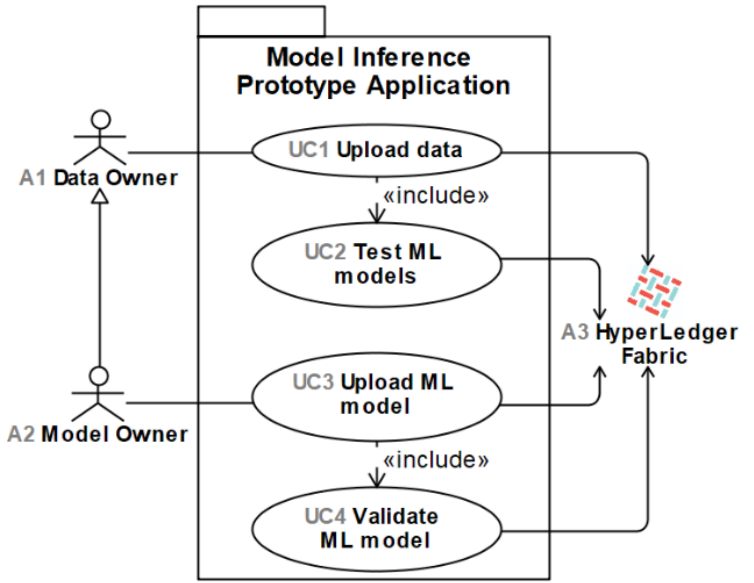
Figure 2. The main functionality of the blockchain-based model inference application: UML use case diagram.